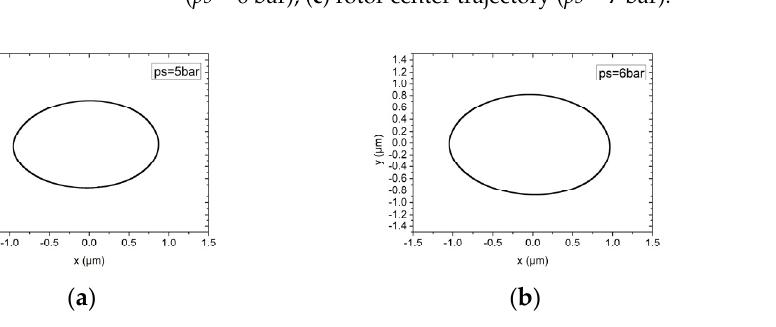
Figure 18. Rotor center trajectory under different supply pressure under working condition 6 (high speed, dynamic unbalance G0.1). ( a ) Rotor center trajectory( ps = 5 bar), ( b ) Rotor center trajectory ( ps = 6 bar), ( c ) rotor center trajectory ( ps = 7 bar).